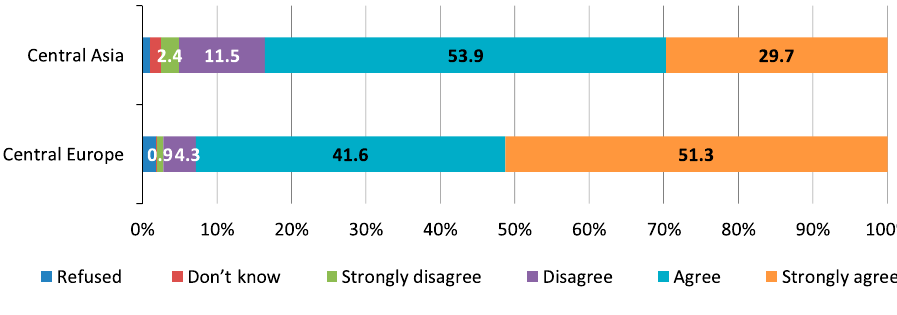
Source: own elaboration based on LiTS III (2016). Figure 2. Descriptive statistics of women’s agreement with the statement by the country